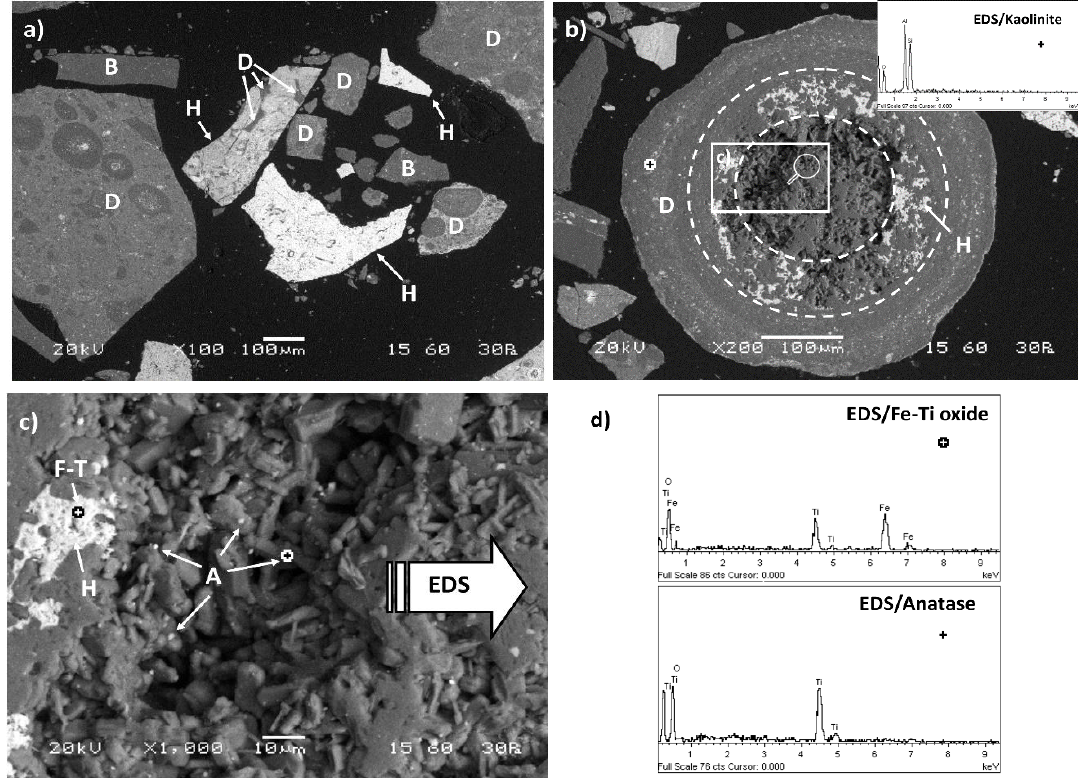
Figure 4. ( a–c ) Cross sectional SEM- backscattered electron (BSE) images of polished surfaces of bauxite ore (crushed product −3.35 mm). EDS spectra obtained in several spot locations ( b–d ) show the presence of oxide phases, the mineral formation of the bauxite clasts and mixed/intergrown oxides in the diasporic matrix (D: Diaspore; B: Boehmite; H: Hematite; A: Anatase; K: Kaolinite; F-T: Fe-Ti oxide)